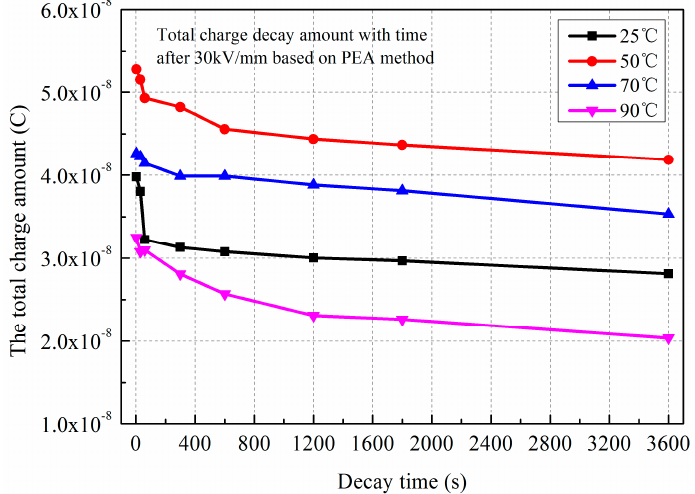
Figure 5. The total charge decay amount versus the polarization temperature under 30 kV/mm. Obtained by PEA method.